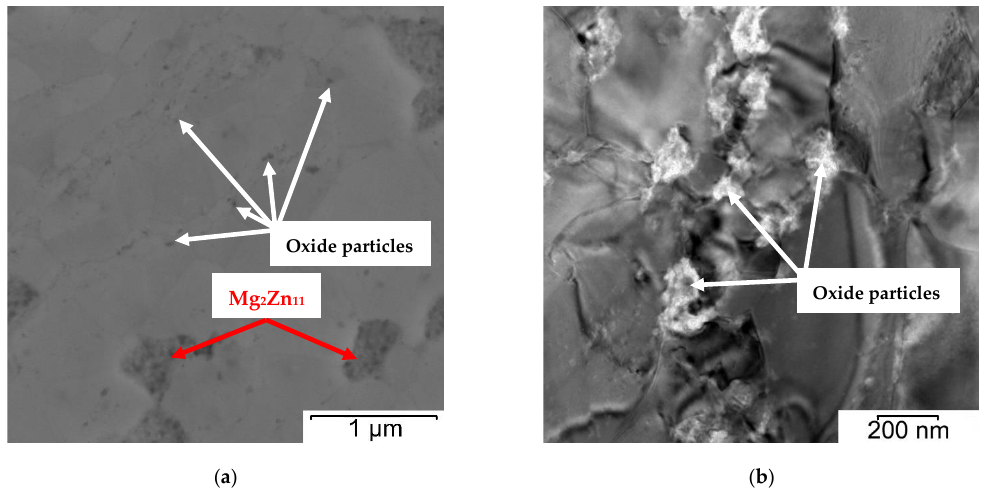
Figure 5 . Microstructure of Zn – 1Mg – 0.5Sr with marked small oxide particles at grain boundaries and intermetallic phase Mg 2 Zn 11 : ( a ) overview (SEM), ( b ) detail (TEM).